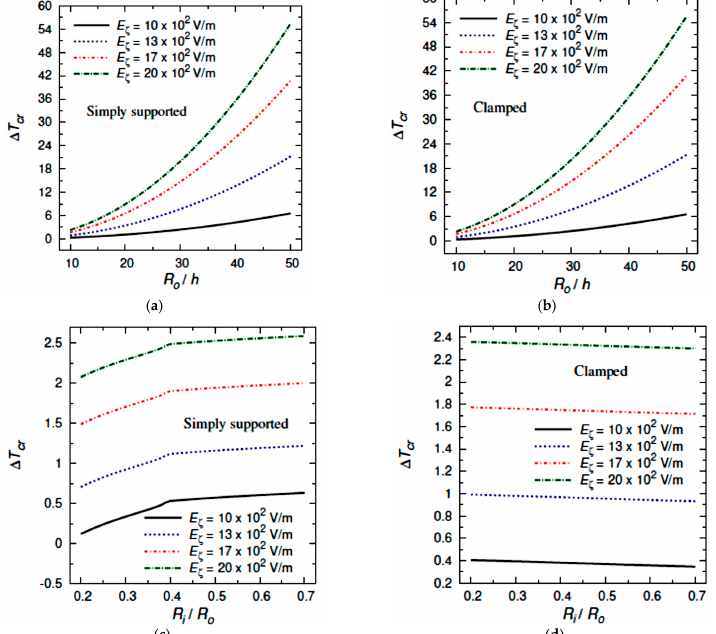
Figure 8. Critical buckling temperature ∆ T cr of ( a ) simply supported plates versus the ratio R o / h , ( b ) clamped plates versus the ratio R o / h , ( c ) simply supported plates versus the ratio R i / R o and ( d ) clamped plates versus the ratio R i / R o for different values of electric field ( κ = 1, ∆ C = 0.5%, e 0 = 10, w g = 0.1%, µ = γ = 2 nm, J 1 = 1000, J 2 =